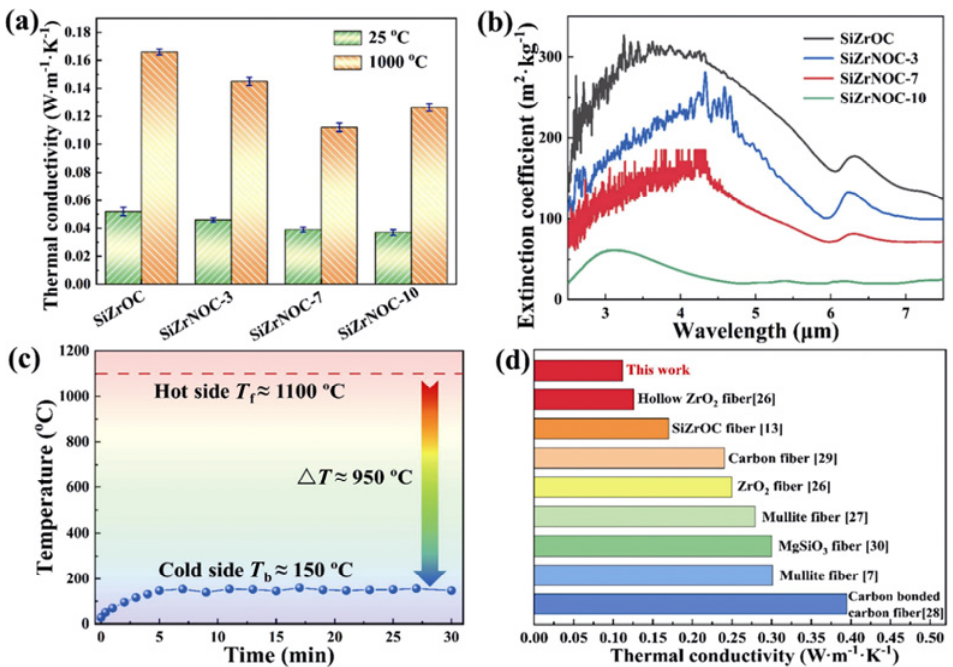
Fig. 6 (a) λ of SiZrOC and SiZrNOC NFMs at 25 and 1000 ℃ , (b) e of SiZrOC and SiZrNOC NFMs, (c) time-dependent temperature curve on cold side of SiZrNOC NFM heated by butane blowtorch flame, and (d) comparison of λ among different ceramic fibers at 1000 ℃